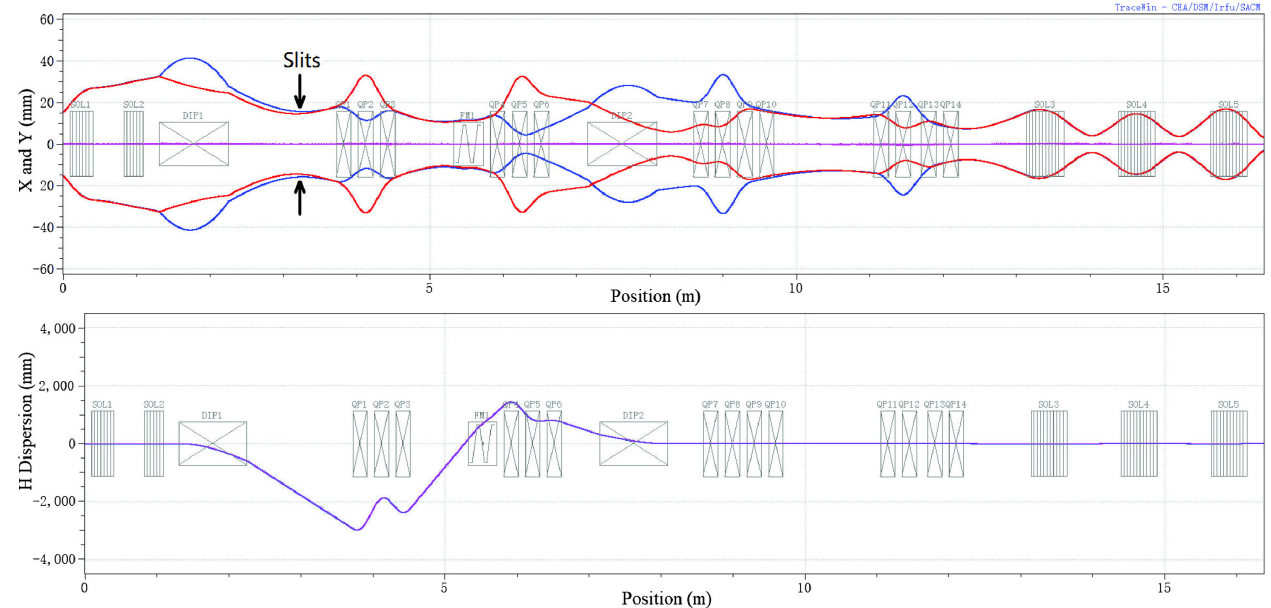
FIG. 15. Simulated beam 2*rms envelope and dispersion function along the LEBT by T race W in